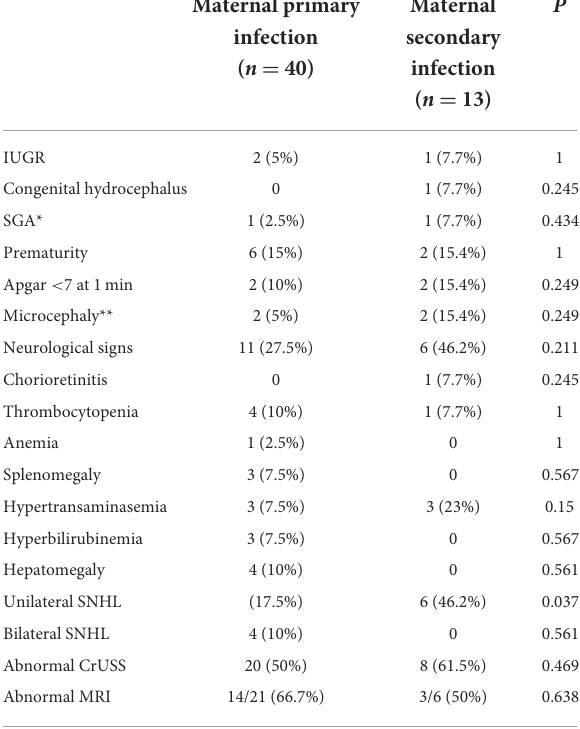
TABLE 1 Signs and symptoms presented at birth by 53 symptomatic children divided according to the type of maternal CMV infection (primary or